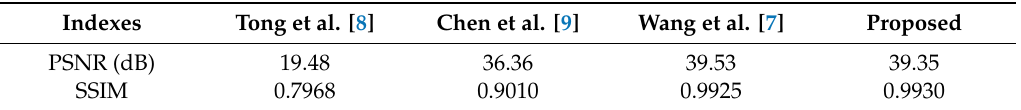
Table 6. Objective comparison of the recovery performances for the content-only attack on the Clock